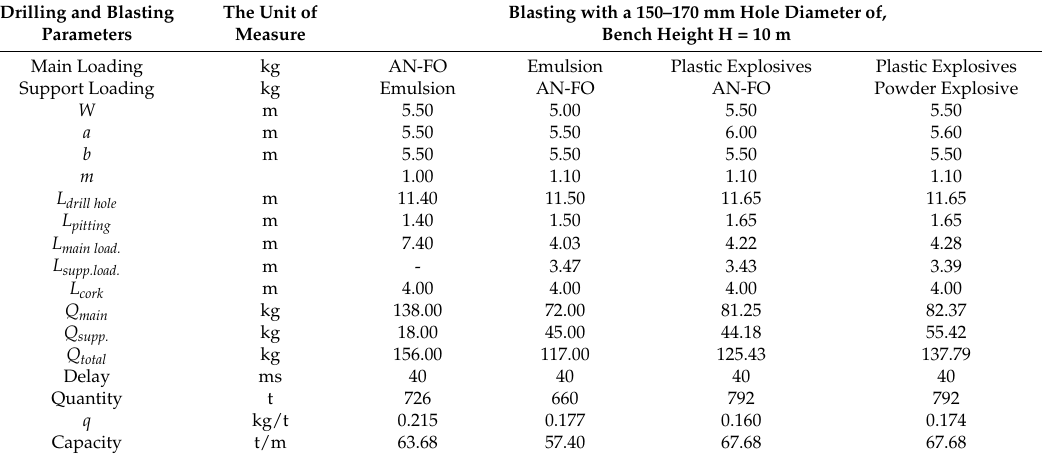
Table 1. Summary of drilling and blasting parameters with the use of rotary percussive drills at the “Buvaˇc” open pit